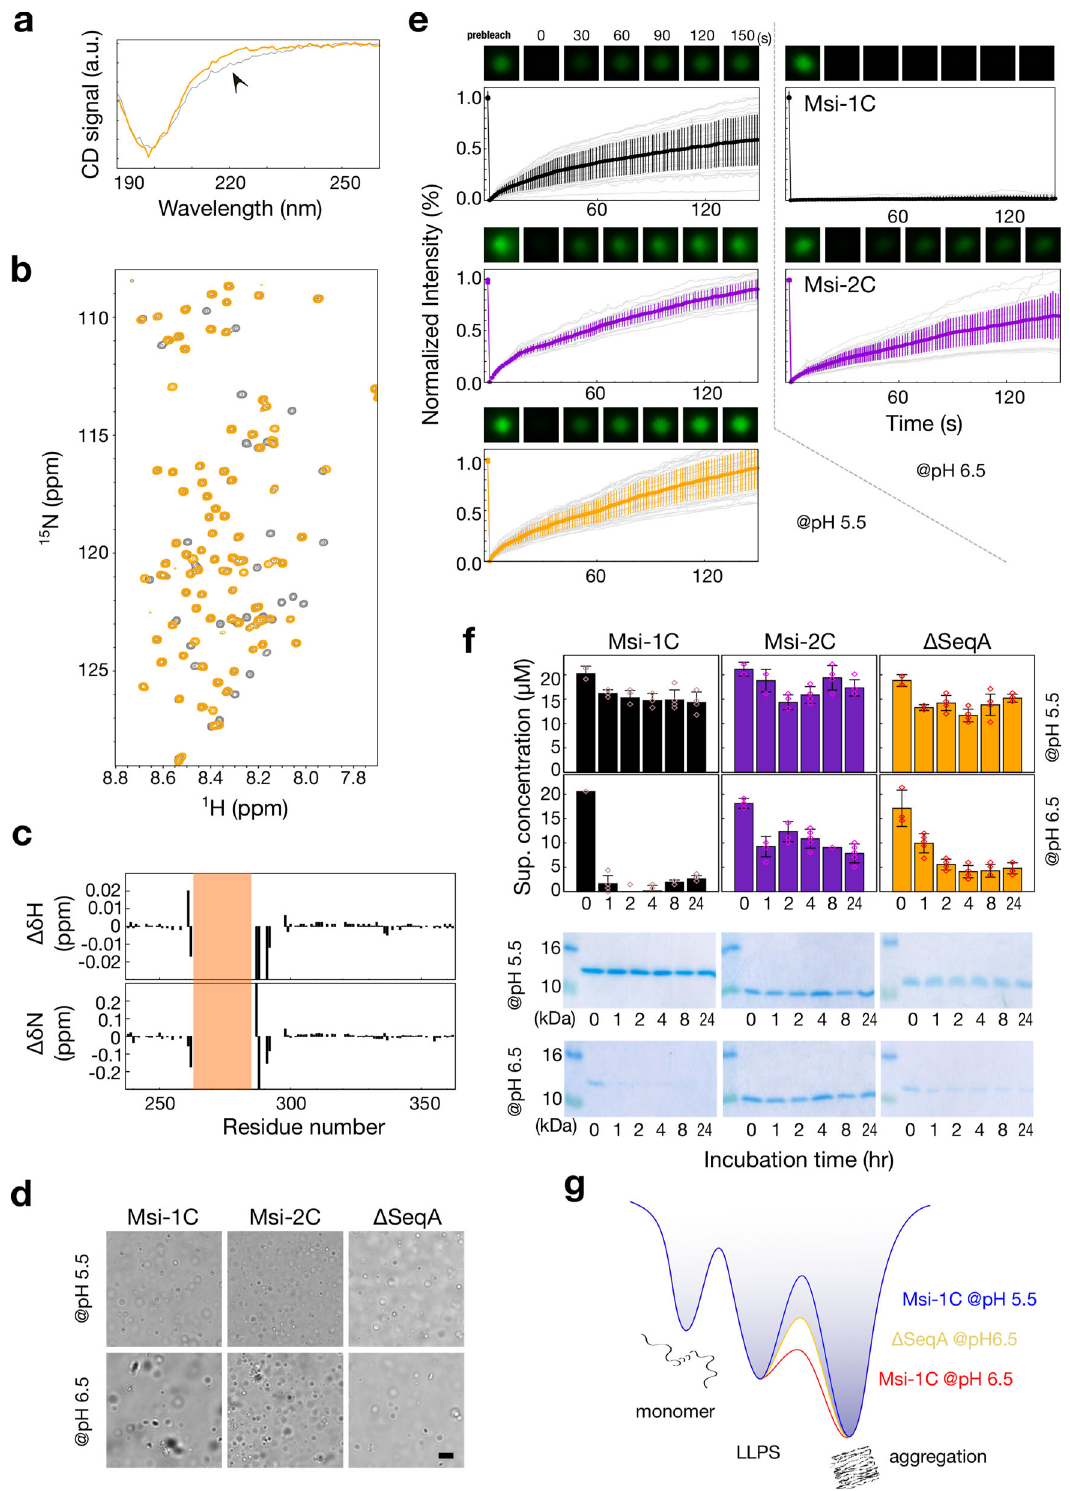
Fig. 4 The α -helical region promotes self-assembly in Musashi-1 ’ s C-terminal domain (Msi-1C). Overlaid a circular dichroism and b NMR HSQC spectra of the Δ SeqA construct (orange) and Msi-1C (gray). c Chemical shift differences in the proton ( Δδ H) and nitrogen ( Δδ N) dimensions between Δ SeqA and Msi-1C. The polyalanine region is highlighted in orange. d Light micrographs of Msi-1C, Msi-2C, and Δ SeqA at pH 5.5 or 6.5. Scale bar: 10 µ m. Experiments were performed at least three times for each protein sample. e Fluorescence recovery after photobleaching (FRAP) results in pH 5.5 and 6.5. The colored lines represent the mean ± SD and the gray lines are individual recovery pro fi les. At least 20 condensates were recorded for each sample. f Precipitation assays of Msi-1C, Msi-2C, and Δ SeqA at pH 5.5 and 6.5 after incubation at room temperature for different time periods. Supernatant concentrations were determined after centrifugation (triplicate; mean ± SD) and con fi rmed by SDS-PAGE. g Energy landscape representation of the results.